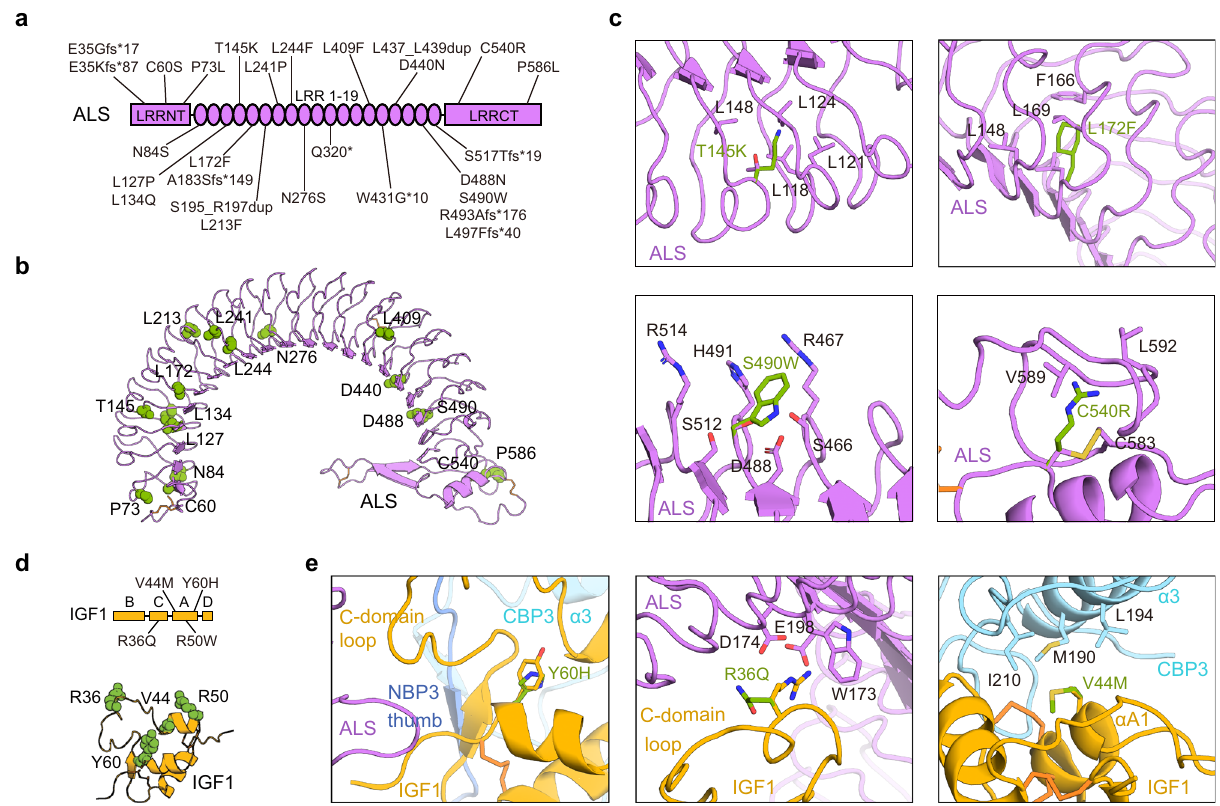
Fig. 4 | Structural basis for disease-associated ALS and IGF1 mutations. a Schematic representation of the ALS protein indicating the location of the 27 identi fi edmutationsfrompatientswithASCLD. b Mutatedresiduesinpatientswith ASCLD (only point mutations) are presented as green spheres and labeled in the cartoon structure of human ALS. c Close-up views of four cases (T145K, L172F,